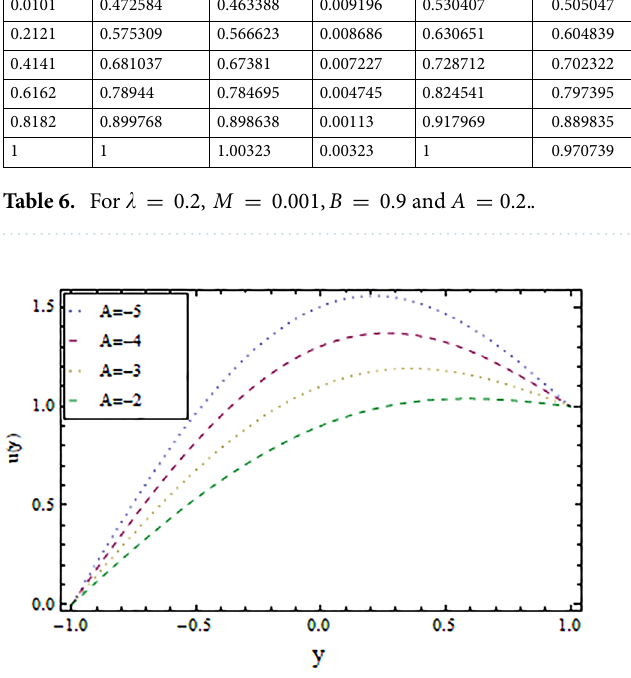
Figure 2. Velocity profile for M = 0.0002, B = 0.3and (cid:31) = 3 using